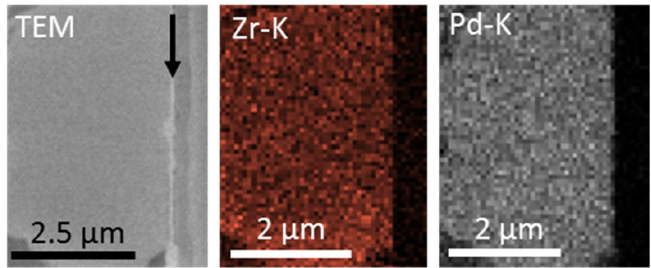
Figure 5. ( Left panel ) TEM image and complementary EDX analyses of a FIB ‐ cut layer of the Pd ‐ Zr system with nominal starting stoichiometry of Pd:Zr = 2:1 before MSR; ( Middle panel ) Zr ‐ K intensity (red); and ( Right panel ) Pd ‐ K intensity (grey). The surface has been denoted by a black arrow. In the right part of the left image, part of the FIB ‐ protecting Pt layer can be seen.